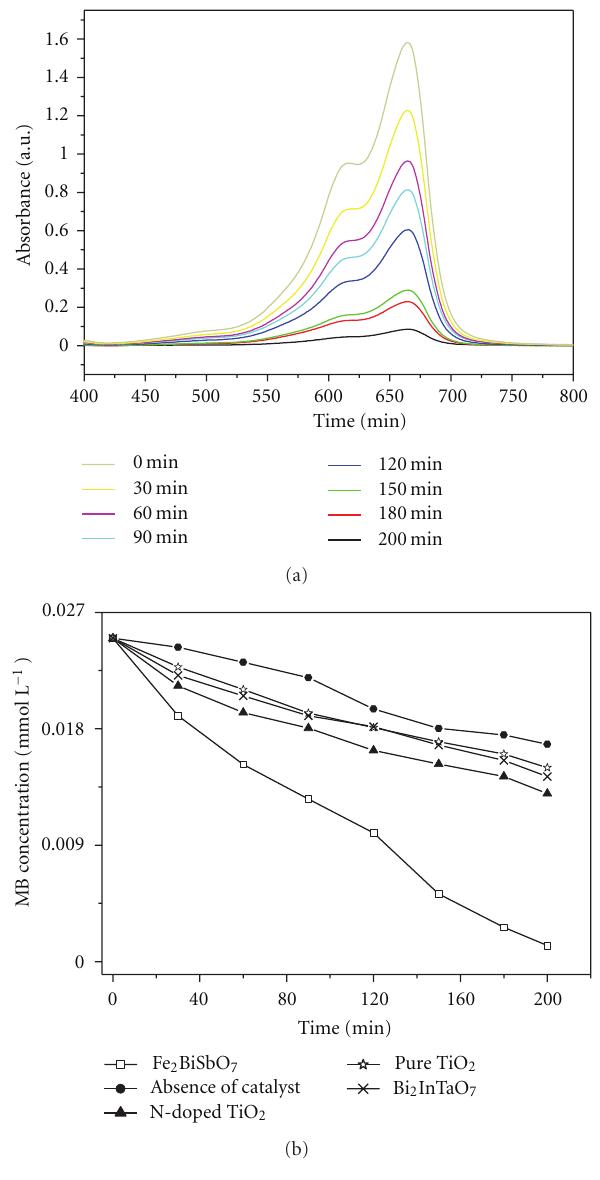
Figure 3: The absorbance pattern of methylene blue photocatalyt- ically degraded by Fe 2 BiSbO 7 (a), and photocatalytic degradation of methylene blue under visible light irradiation in the presence of Fe 2 BiSbO 7 , Bi 2 InTaO 7 , pure TiO 2 , N-doped TiO 2 , as well as in the absence of a photocatalyst (b).